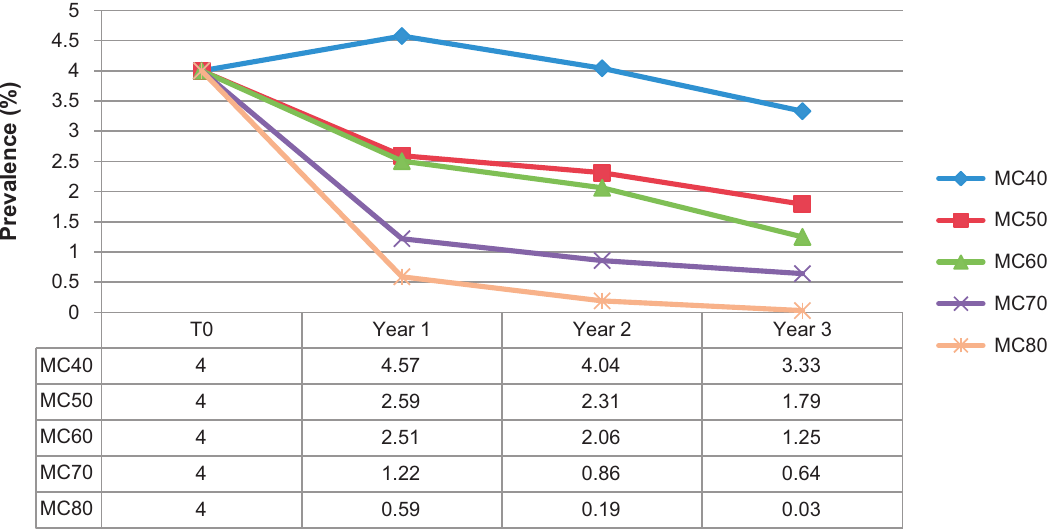
Figure 4. Sensitivity test about the evolution of the average prevalence of sleeping sickness during 3 years, using 5 different percentages (40, 50, 60, 70 and 80%) of medical covers